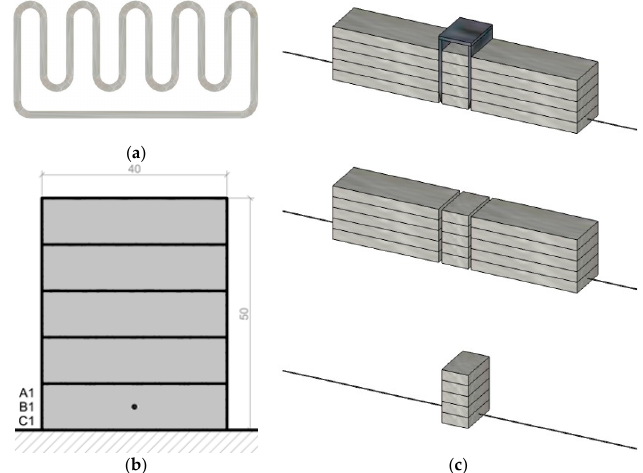
Figure 4. ( a ) Print path; ( b ) and transverse section of printed objects from which the respective specimens were obtained; ( c ) cutting and stripping of printed specimens.